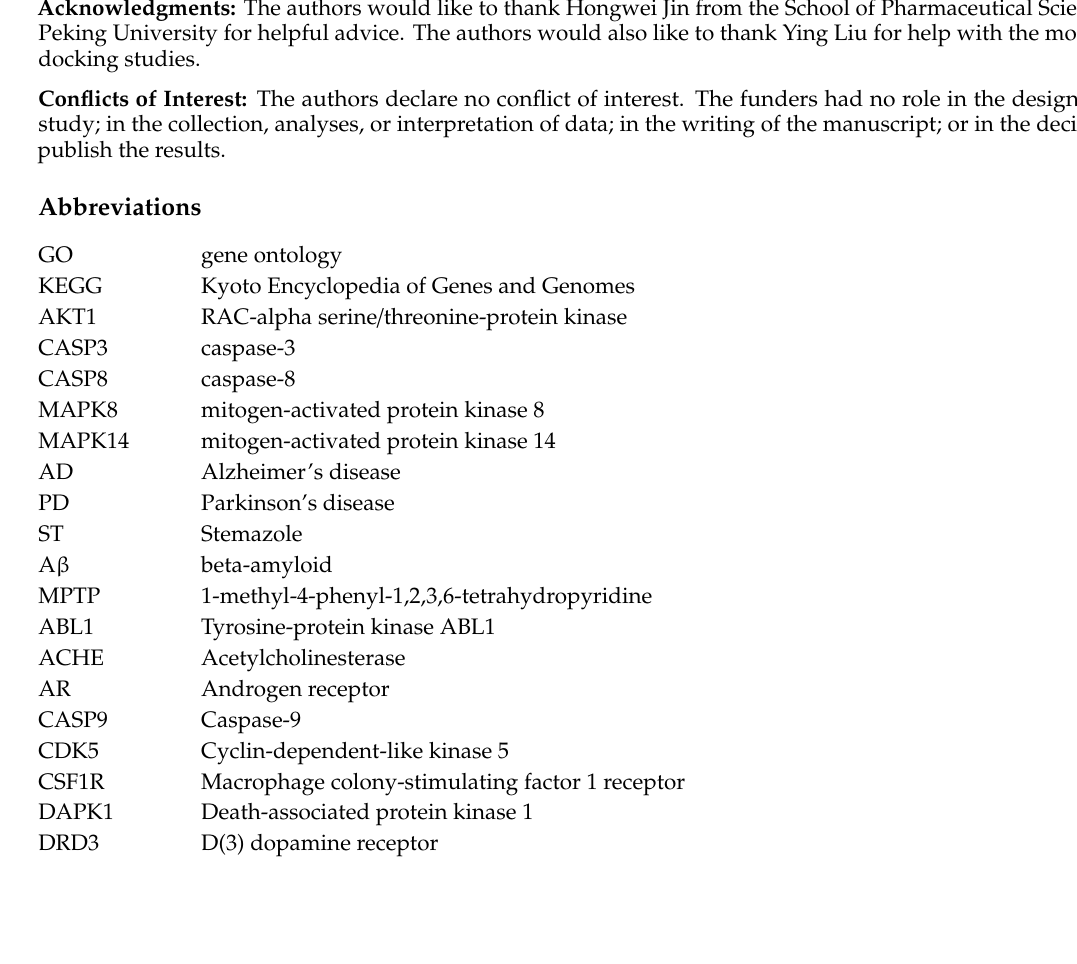
Table S1: Targets associated with Alzheimer’s disease and Parkinson’s disease, Table S2: Predicted targets of stemazole, Table S3: The results of the GO and KEGG pathway